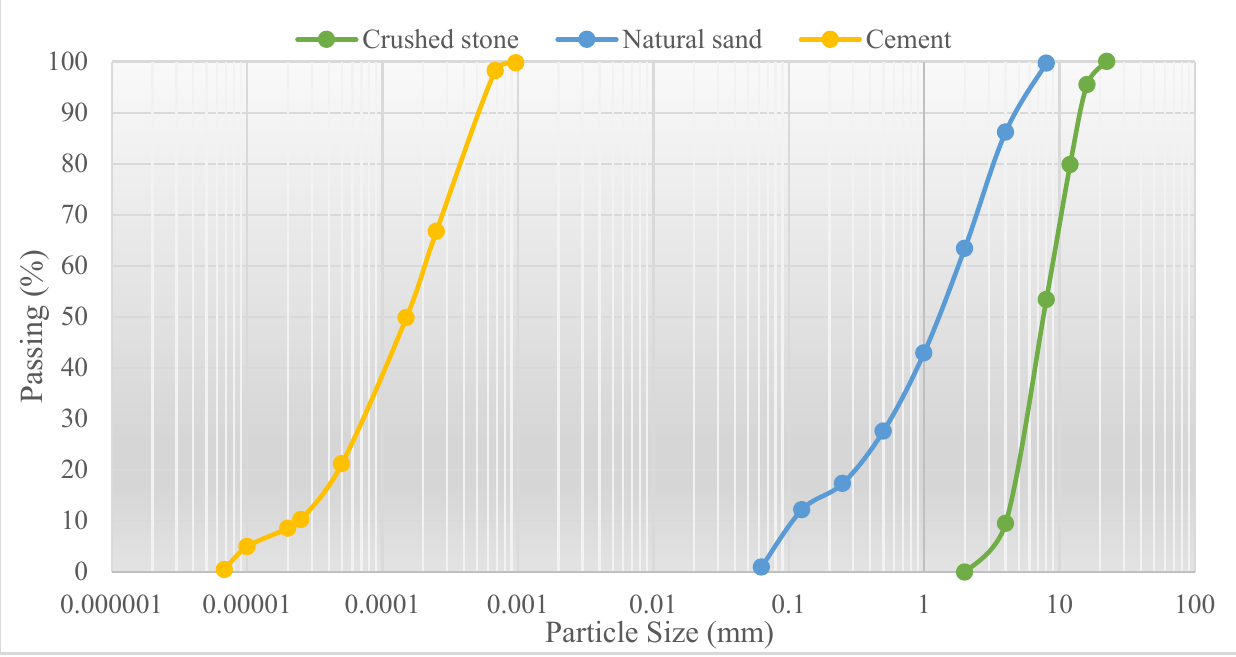
Figure 1. Particle size distribution of aggregate.